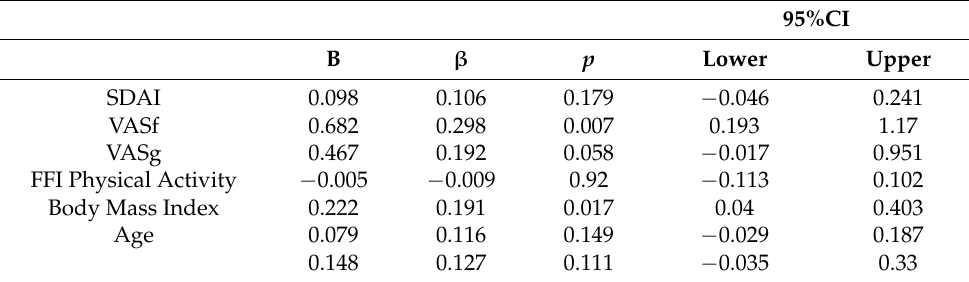
Table 3. Model of multivariable regression for the association of